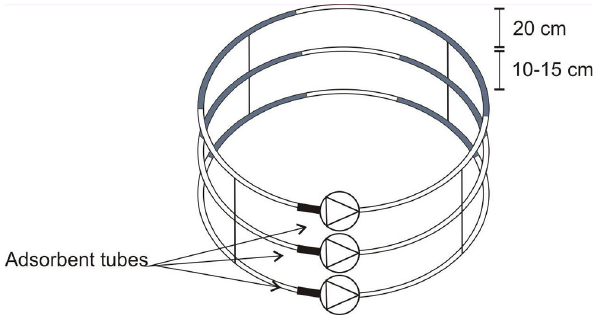
Fig. 1. Schematic figure of VOC snow profile. Grey areas represent perforated